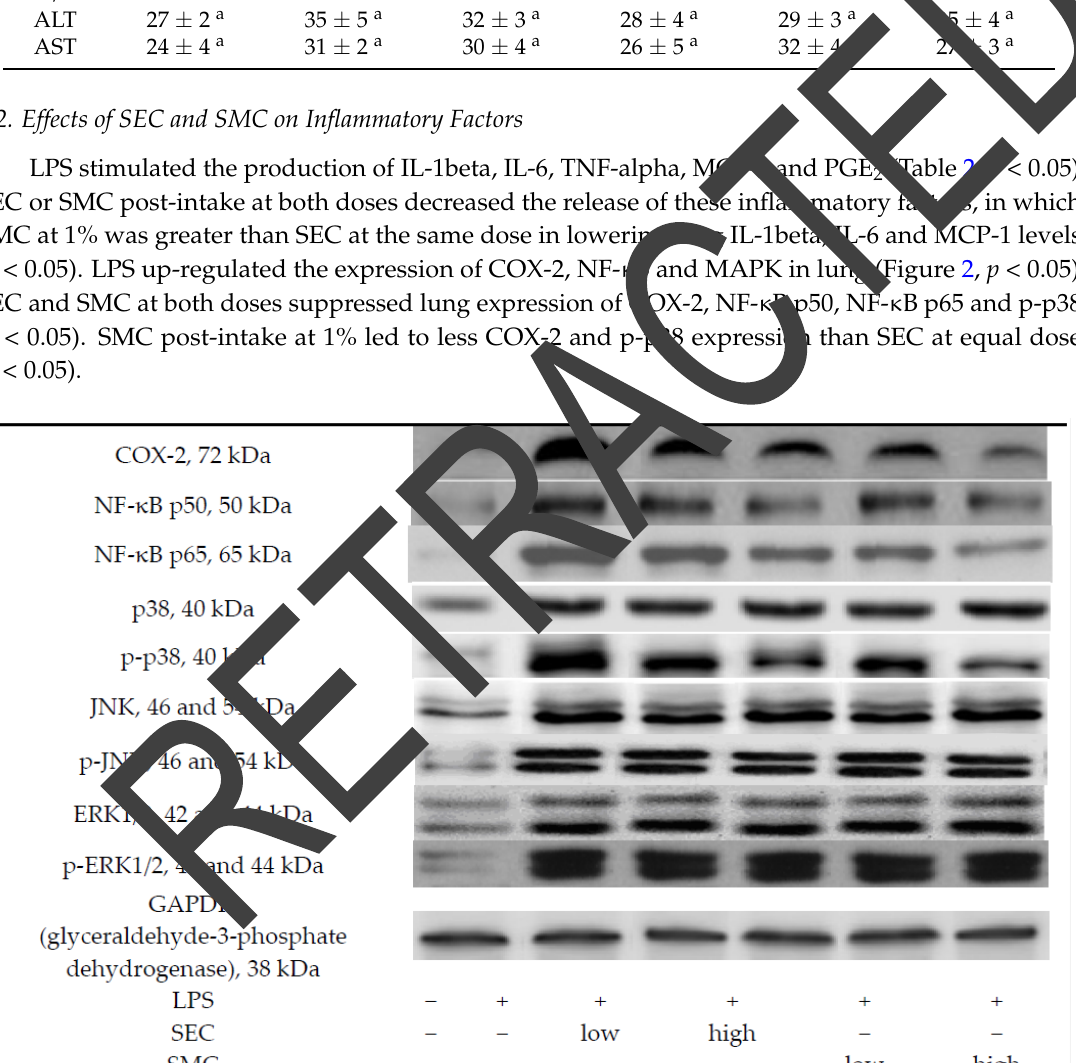
Figure 1. Lung MPO (myeloperoxidase) activity ( a ); and neutrophil count ( b ) of mice in normal group, LPS (lipopolysaccharide) group, LPS + low SEC ( S ‐ ethyl cysteine) group, LPS + high SEC group, LPS + low SMC ( S ‐ methyl cysteine) group and LPS + high SMC group after 3 ‐ day treatments. Data are mean ± SD (standard